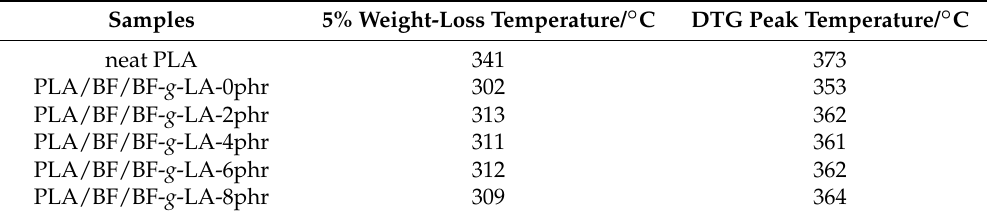
Table 6. Thermogravimetric temperature of PLA/BF/BF- g -LA composites. Samples 5% Weight-Loss Temperature/ ◦ C DTG Peak Temperature/ ◦ C neat PLA 341 373 PLA/BF/BF- g -LA-0phr 302 353